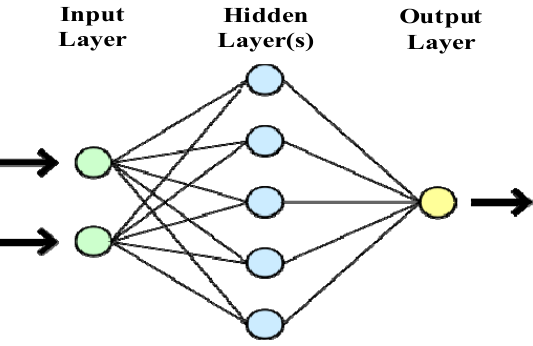
Figure 3. A simple artificial neural network.